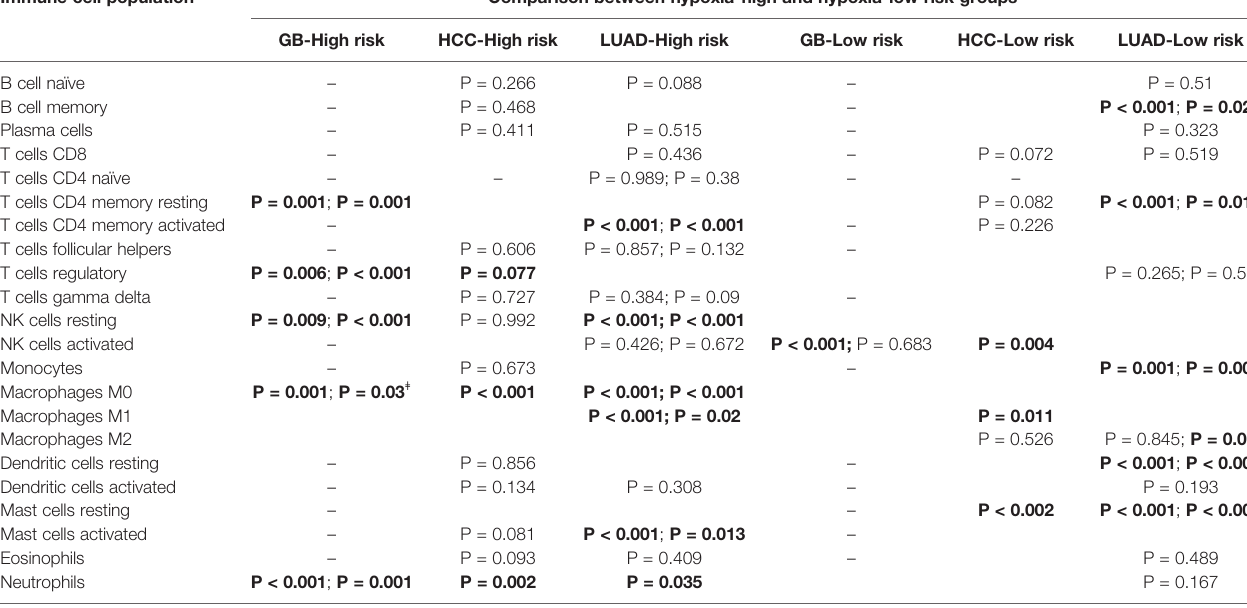
TABLE 3 | Immune cell populations in tumors grouped based on hypoxia risk scores. Immune cell population